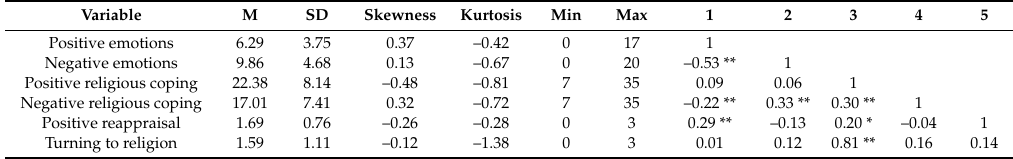
Table 1. Descriptive statistics and correlations among the studied variables ( N =